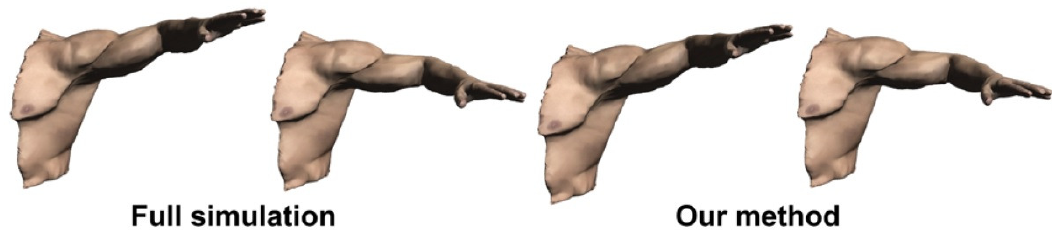
Figure 28. The proposed method produces a good approximation to the full simulation while being Figure 28. The Proposed Method Produces a Good Approximation to the Full Simulation While Being 60-times faster. The figure is originally from [102]. Reproduced with permission from Jernej Barbic, 60 Times Faster. The figure is originally from [132]. ACM Transactions on Graphics; published by ACM Digital Library,